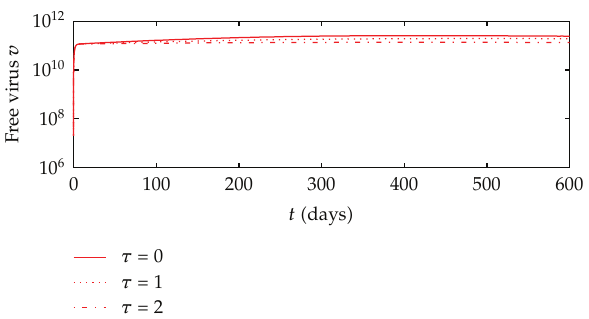
Figure 2: The numerical solution for viral decay of system (cid:3) 1.3 (cid:4) when τ (cid:8) 0 , 1 and 2